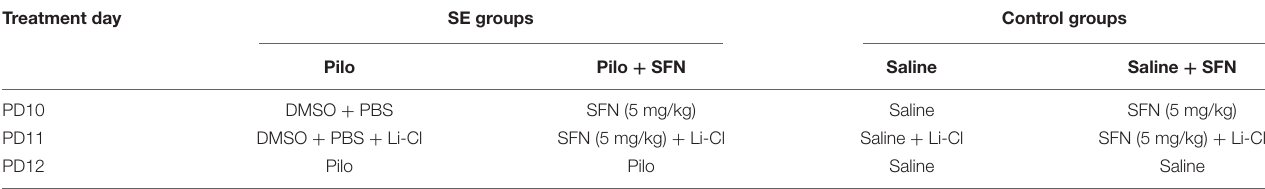
TABLE 1 | Design of experimental